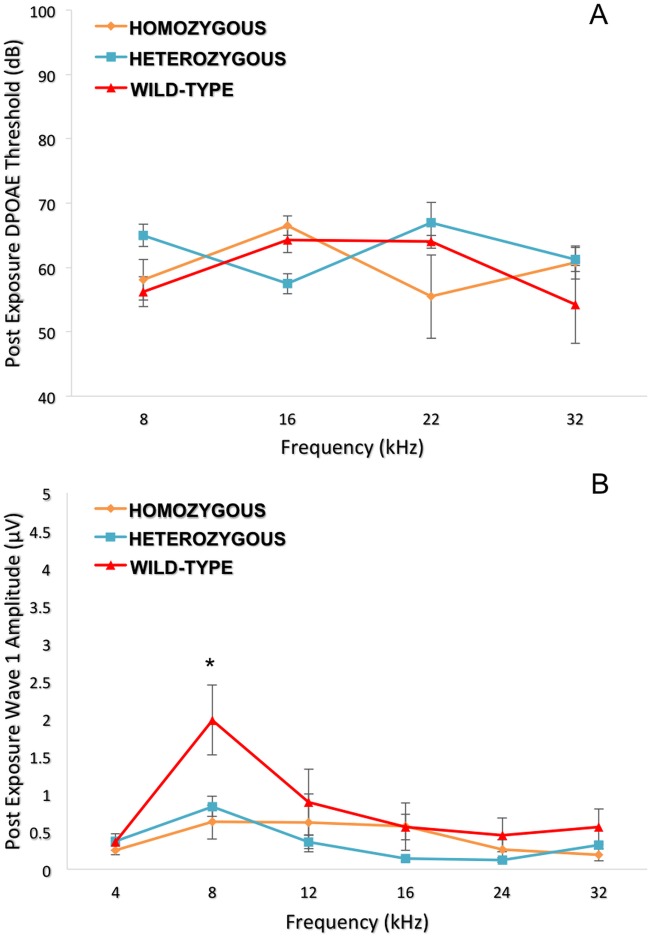
Topographical analysis of the auditory pathway at different frequencies (post-noise exposure).Although no significant difference was seen for the DPOAE thresholds (6A), the wild-type controls show a higher wave 1 amplitude (p = 0.010) only at 8 kHz compared to Nox3
het/+ and Nox3
het/Nox3
het (6B). One-way ANOVA (Tukey test for multiple comparisons). * = p < 0.05. Homozygous = Nox3
het/Nox3
het: Heterozygous = Nox3
het/+: Wild-type = C57BL/6JEiJ strain.